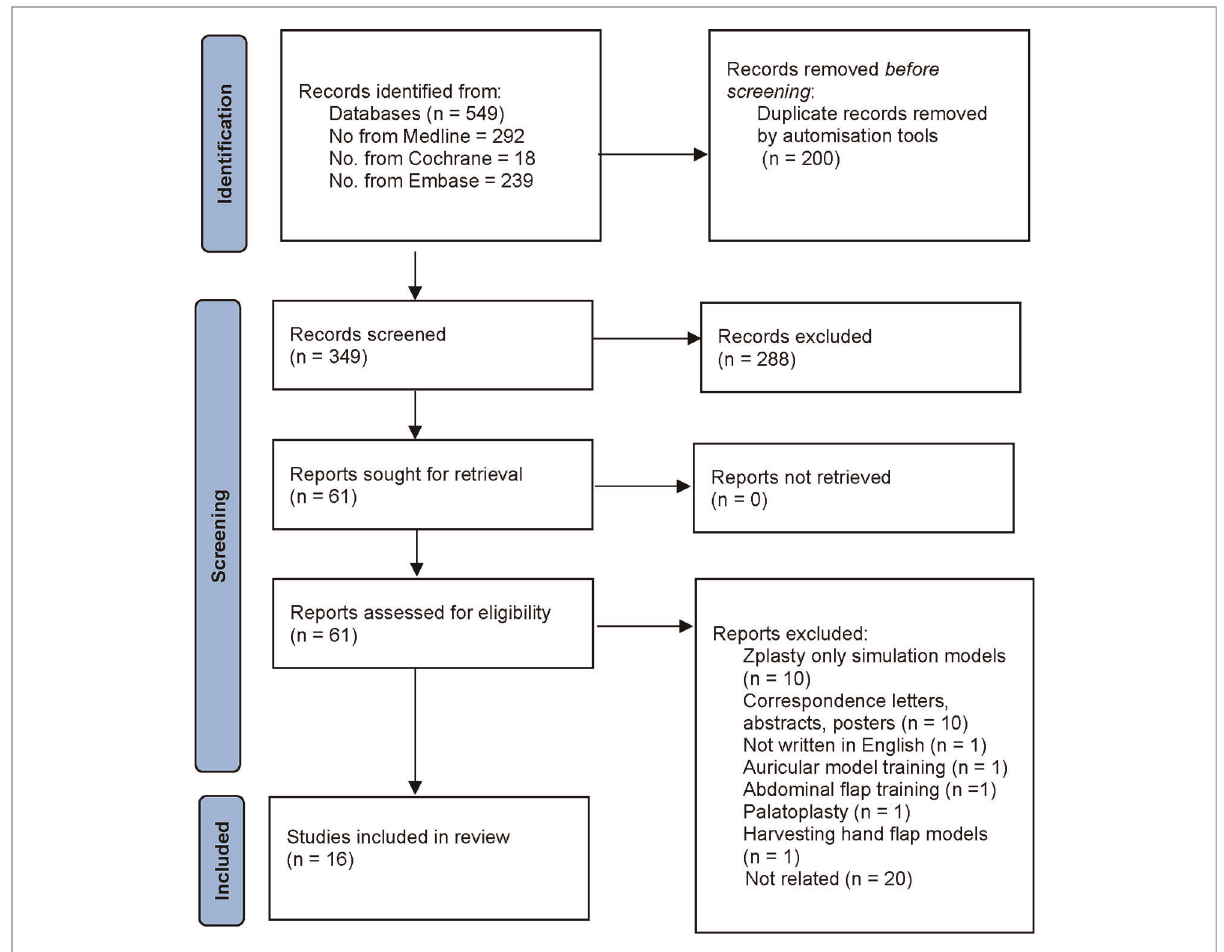
FIGURE 1 Preferred reporting items for conducting systematic reviews of included